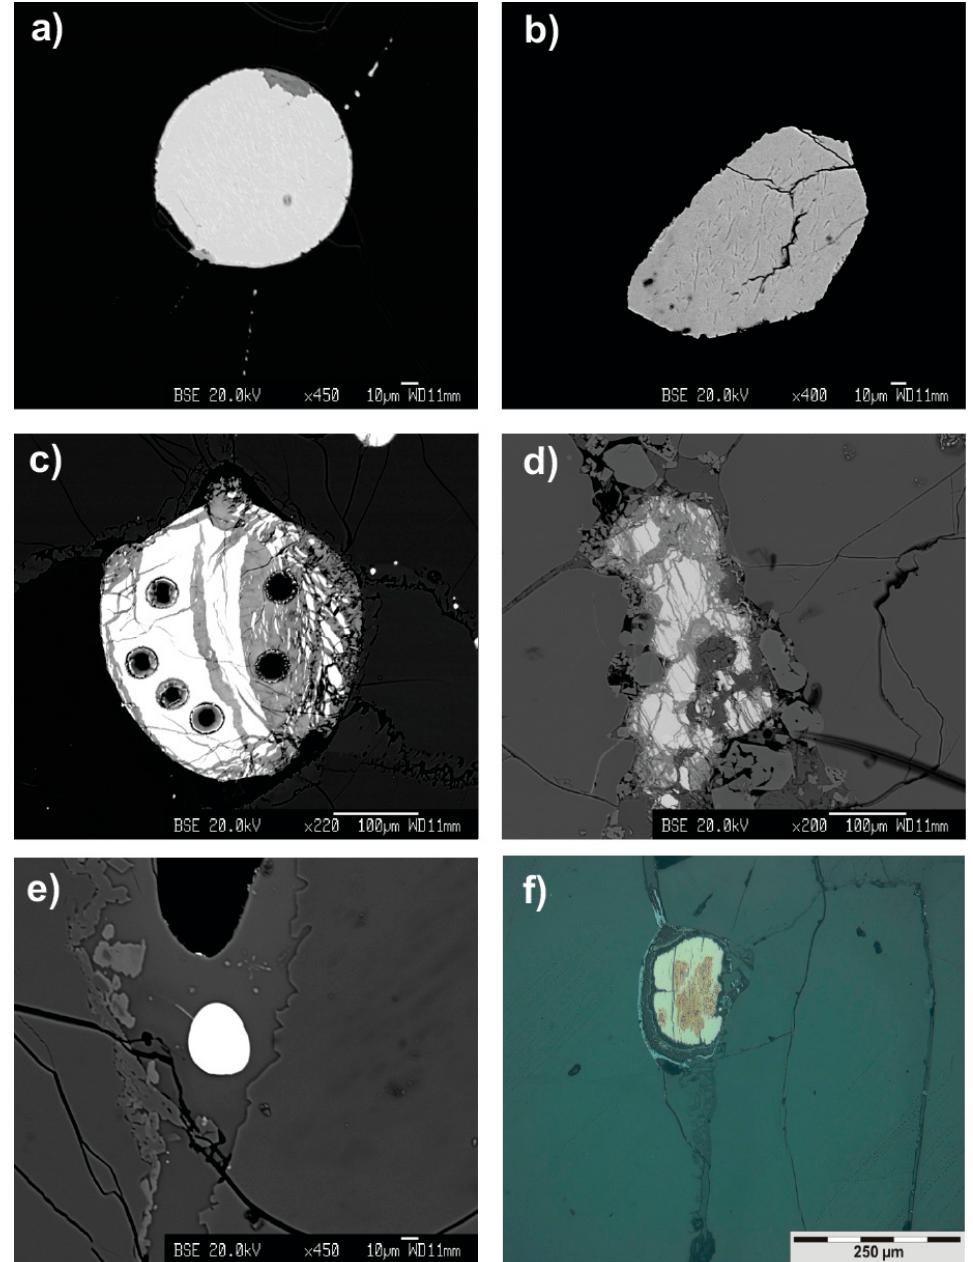
Figure 1. Overview of textural features of Middle Atlas sulfides and hydroxides. ( a ) Back scatter electron (BSE) image of a droplet-shaped monosulfide sulfide solution (mss), which is enclosed in orthopyroxene (Atl-3A). Note the two sulfide melt trails traversing this grain and the fine, slightly lighter-colored exsolution blades of Ni-rich mss, which are also visible in the elemental mapping of this grain provided in Figure S2a. ( b ) BSE image of a euhedral mss with a hexagonal cross-section and darker-colored comparatively Cu-enriched exsolution lamellae (cf. Figure S2b), enclosed in olivine (Atl-3A). ( c ) BSE image of an interstitial mss exhibiting a strong alteration to Fe-hydroxide (Atl-3E). Laser ablation inductively coupled plasma mass spectrometry (LA-ICP-MS) spots are 25 µm in diameter. ( d ) BSE image of altered interstitial sulfide, consisting of mss and pentlandite, associated with a secondary melt pocket (Atl-3C). ( e ) BSE image of mss in silicate glass of a secondary melt pocket (Atl-3V). ( f ) Micrograph of interstitial mss with reddish-brown comparatively Cu-enriched exsolution lamellae, enclosed by dark grey and bluish-grey Fe-hydroxide phases (Atl-3T). An elemental mapping of this grain is provided in Figure S1.